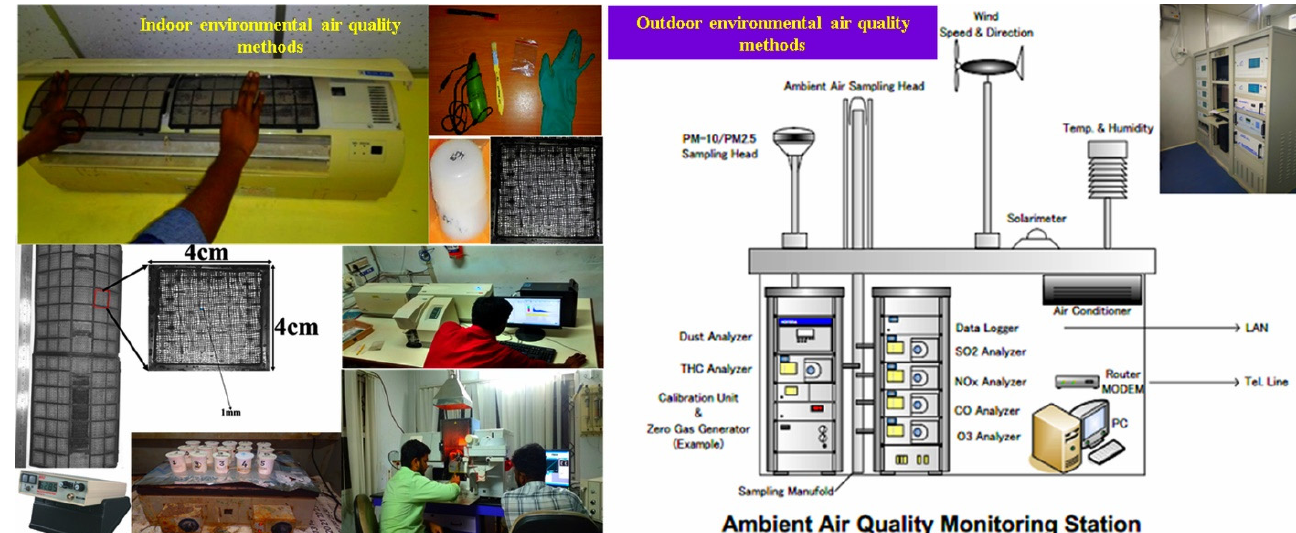
Figure 2. Graphical view of materials and methods adopted for the present study area.